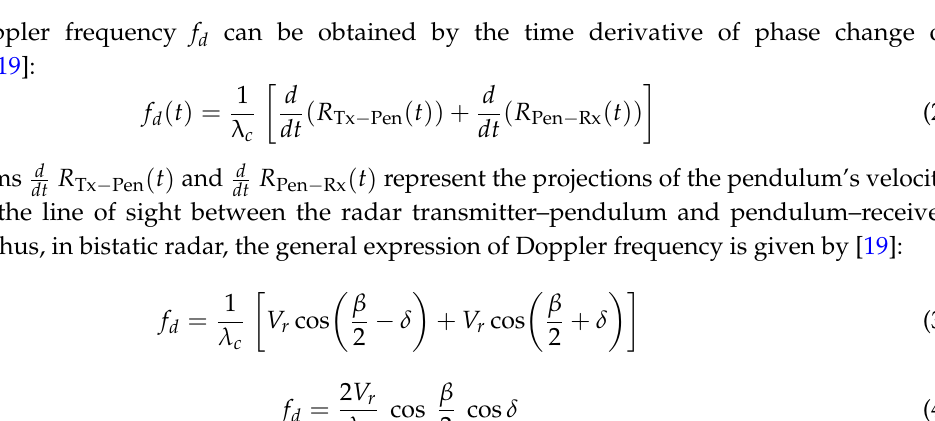
Figure 1. Forward Scatter Radar geometry to observe Doppler from the swinging pendulum crossing Transmitter (Tx)–Receiver(Rx) baseline .